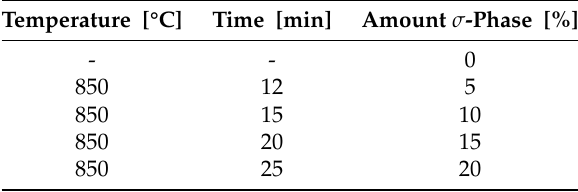
Table 4. Heat treatment and resulting amount of σ -phase in the specimens tested. Temperature [°C] Time